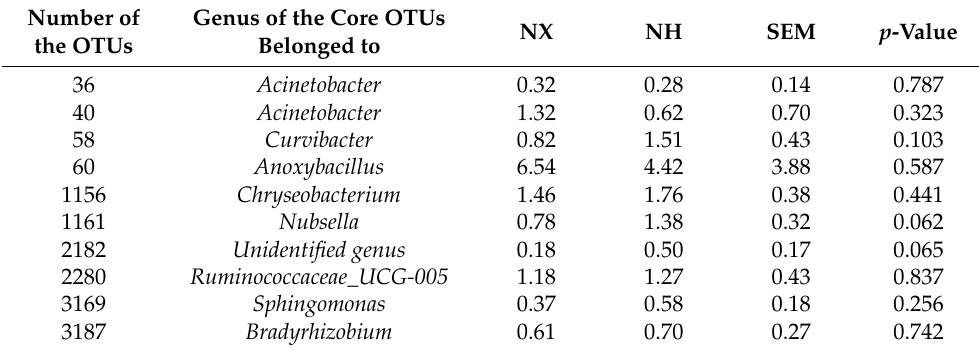
Table 1. The core OTUs across 100% of the collected colostrum samples from the two farms and their relative abundance (%).